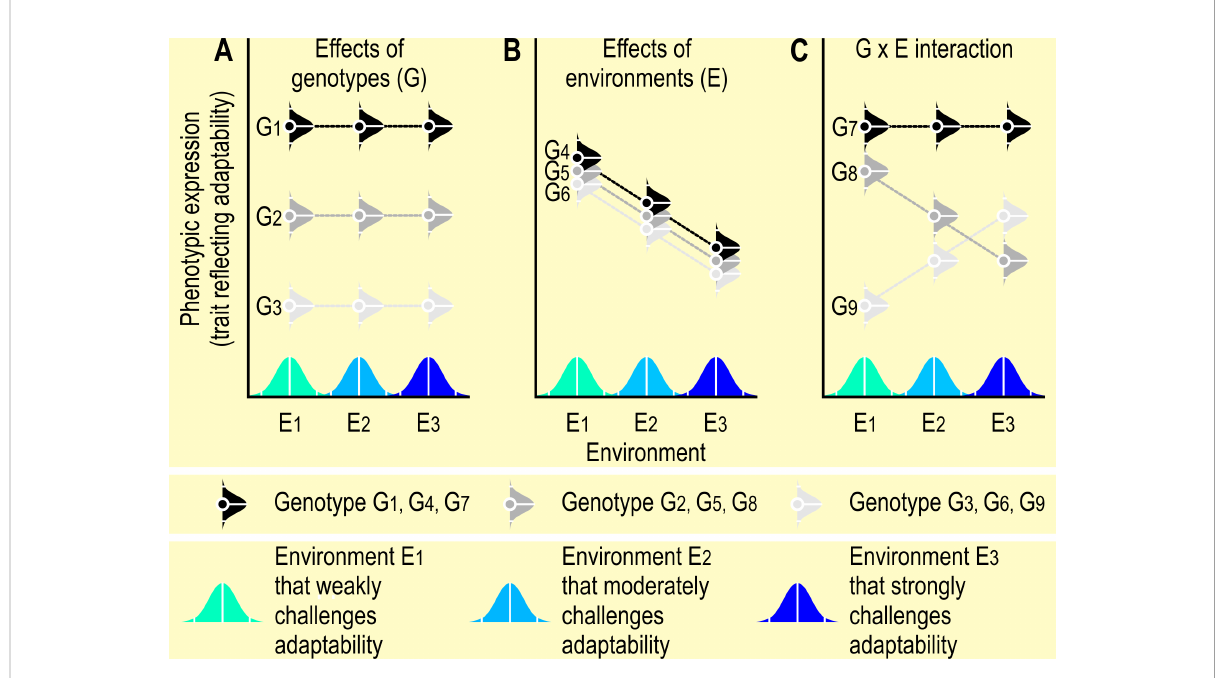
FIGURE 3 Reaction norm curves. Reaction norms are, the “ set of phenotypes that a single genotype produces in a given set of environments ” (Dingemanse et al., 2009, p. 81), i.e. they visualize the effects of environment (E1 – E3) on the phenotypic expression of a trait depending on genotype (G1 – G9). The bell- shaped curves in this fi gure indicate that the environments and the phenotypes are represented by a range of data around a mean environmental gradient (Voelkl and Würbel, 2016). In panel (A) , phenotypic expression depends on genotype, whereas the different environments do not have a differential effect on the phenotype. The environments affect the phenotypic expression in panel (B) , whereas genotype and environment interact in panel (C) (depicted as suggested by Fuller et al., 2005, p. 446, and inspired by S.M. Carr, https://www.mun.ca/biology/scarr/6390_Norm_of_Reaction. html). Note that in these examples, the plots show no change or a linear change across environments. However, the phenotypic expressions of a genotype across a range of environments may be non-linear. Also, the distributions of phenotypic expressions of a genotype may be narrower or wider than the standard normal distributions depicted in this graph. Consequently, knowledge of the reaction norms in one environment may not predict reaction norms in a different environment (Niemelä and Dingemanse,